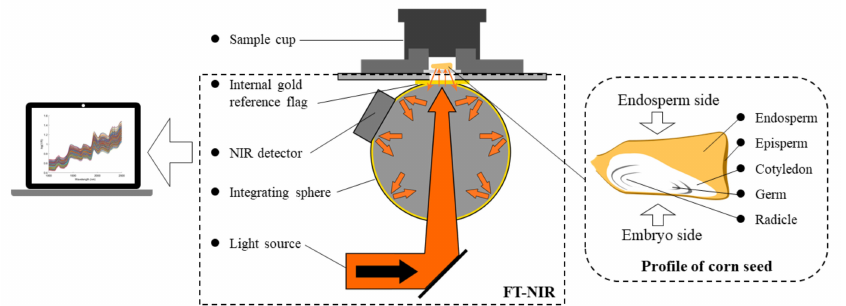
Figure 1. Schematic of using an FT-NIR spectrometer to acquire the NIR spectrum of a single sweet corn seed in a di ff use reflectance mode (left), and the basic biological structure of a sweet corn seed